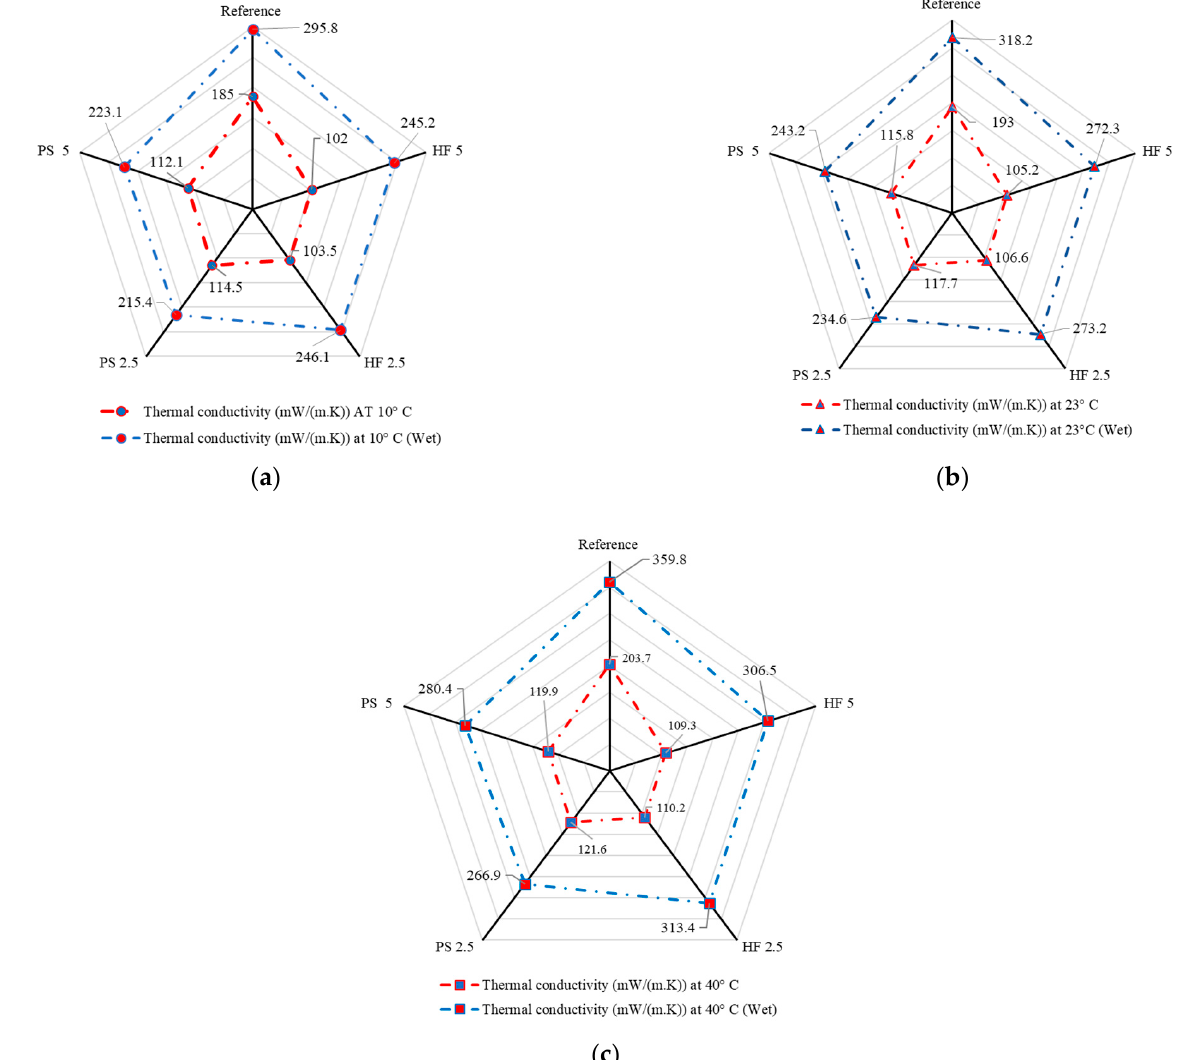
Figure 8. Evolution of the thermal conductivity of fiber mortar at different temperatures, including ( a ) 10, ( b ) 23, and ( c ) 40 °C .